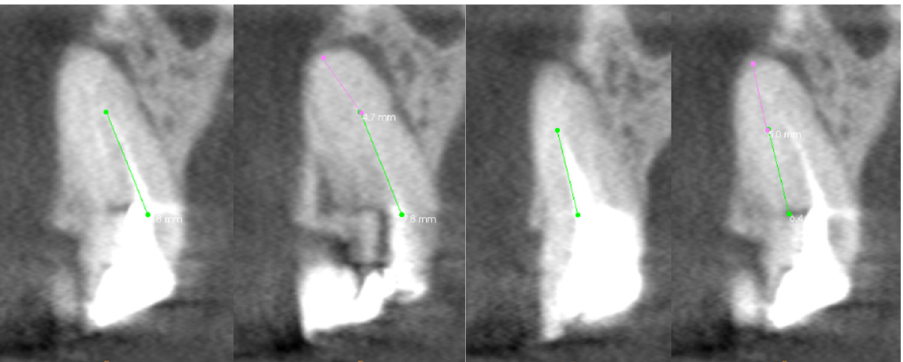
Figure 11. The CT scan of the tooth was used for the analysis of the root canals in the transverse plane, in the case of tooth 15.